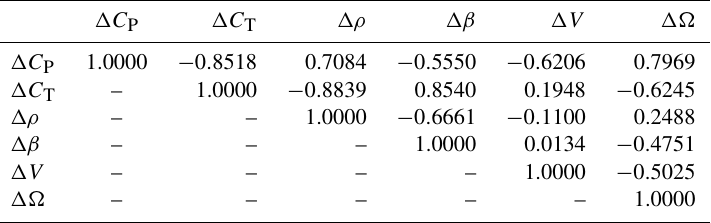
Figure 5. Lift C L (a) and drag C D (b) coefficients as functions of angle of attack α for various Reynolds numbers. Dashed lines: nominal values according to Bottasso et al. (2014a); solid lines: new identified values. Table 2. Correlation coefficients among inputs and outputs.